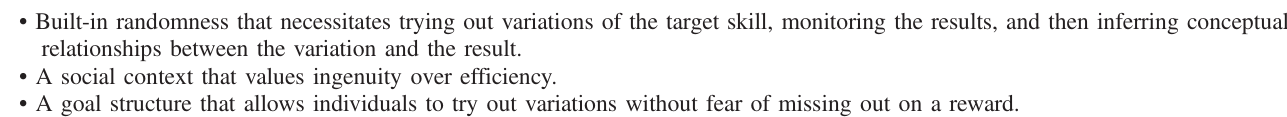
TABLE III. Conditions for adaptive expertise. (cid:129) Built-in randomness that necessitates trying out variations of the target skill, monitoring the results, and then inferring conceptual relationships between the variation and the result. (cid:129) A social context that values ingenuity over efficiency. (cid:129) A goal structure that allows individuals to try out variations without fear of missing out on a